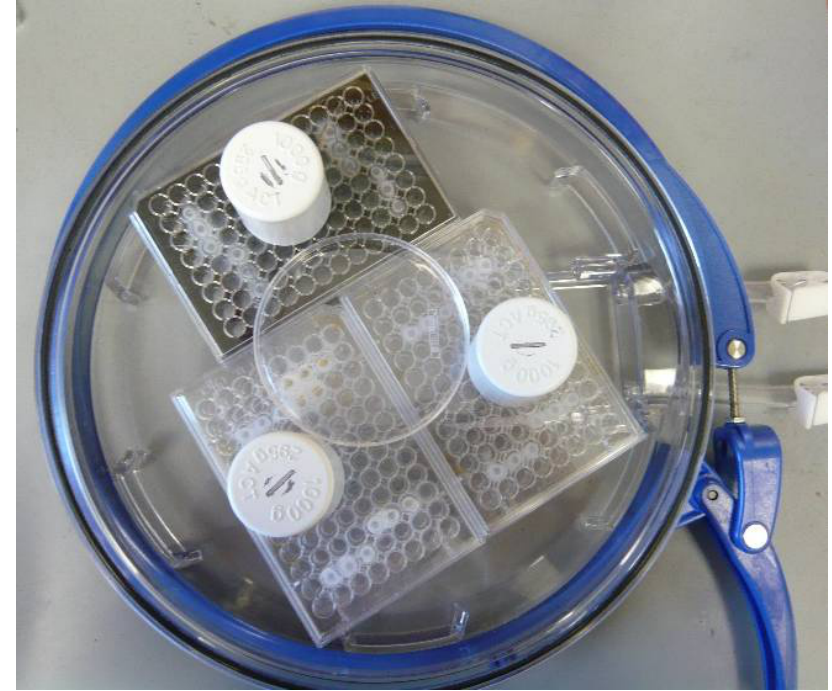
Figure 2. Image of compressed plates within the hypoxic chamber. Weights of 1000 g were placed on top of the self-constructed compression lids to apply a force of 9.81 N to an area of 0.079 cm 2 per well.